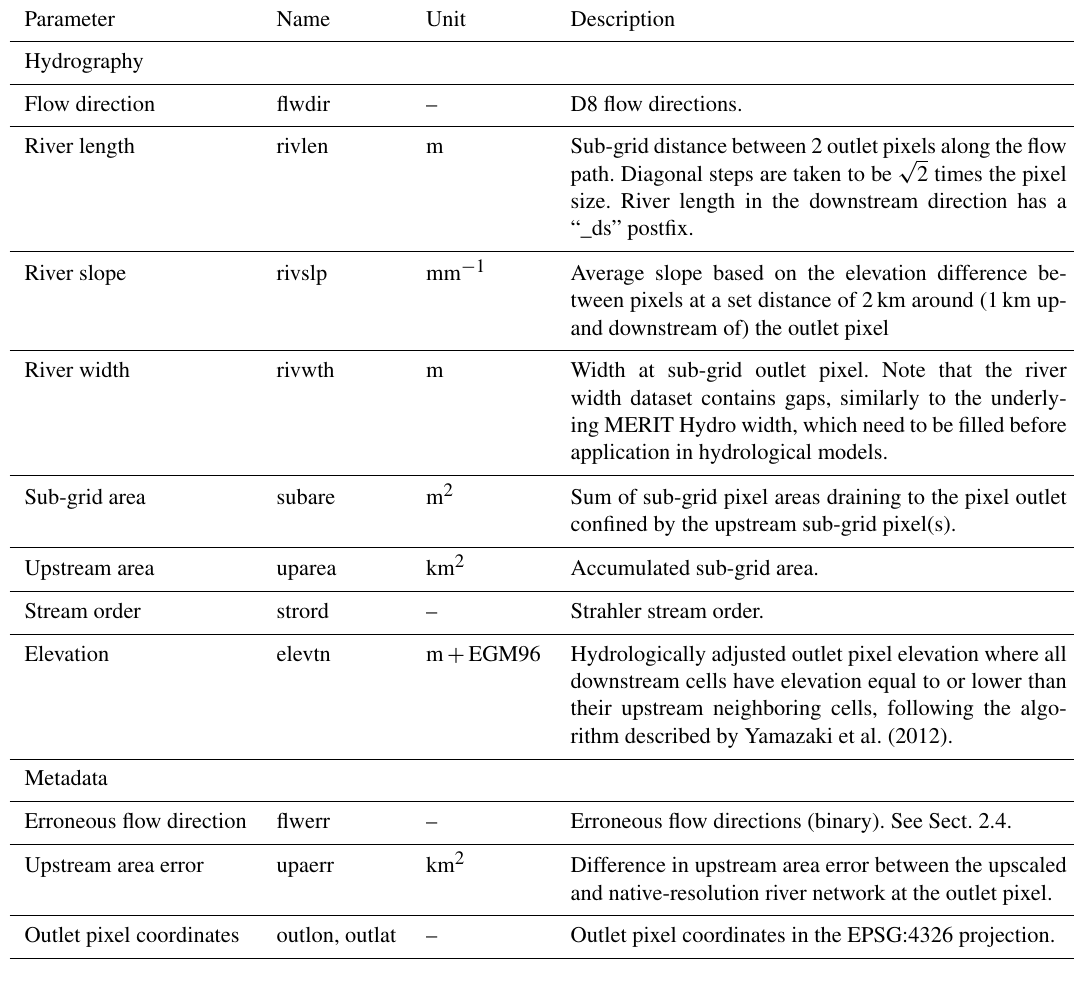
Table 1. Overview of hydrography and metadata layers of the MERIT Hydro IHU v1